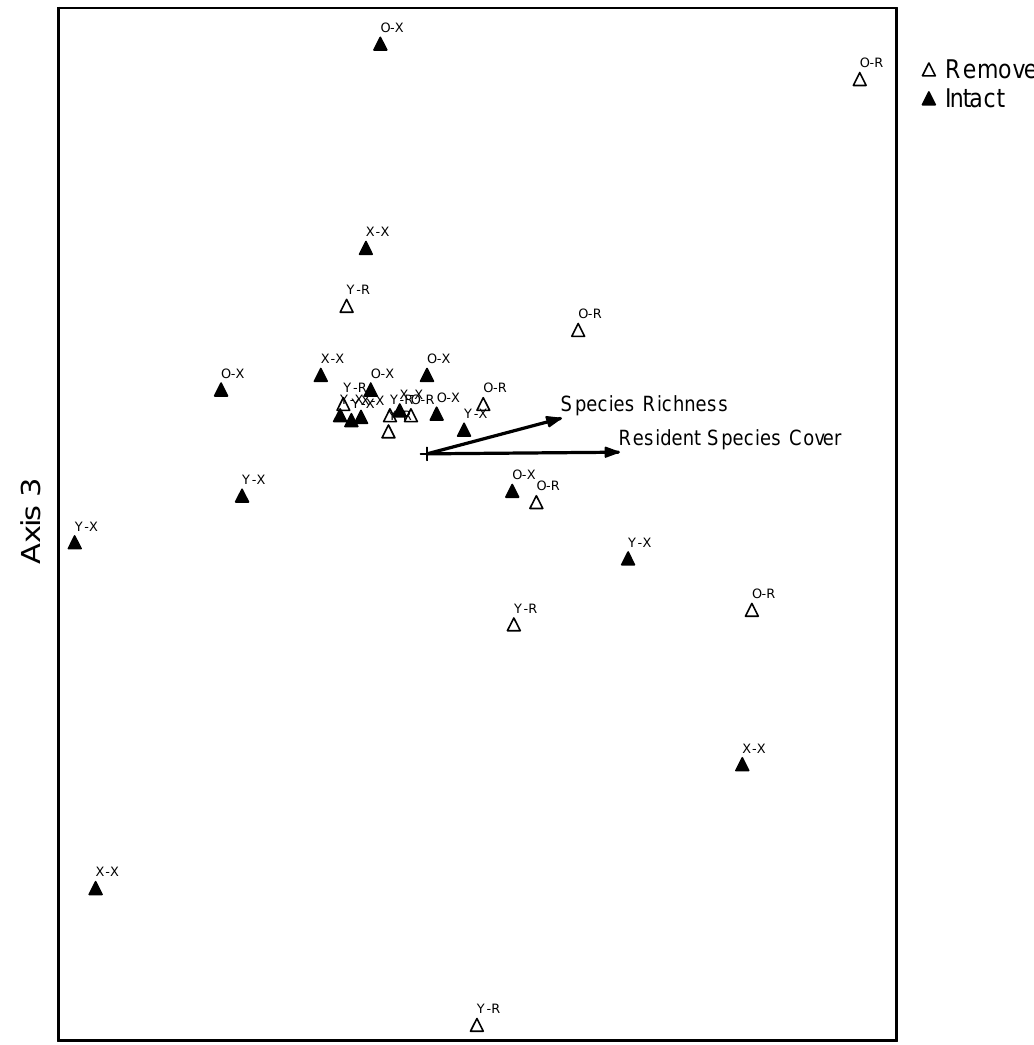
Figure 5. NMDS (nonmetric multidimensional scaling) for variable combinations in resident species space reflecting change in species composition two years after